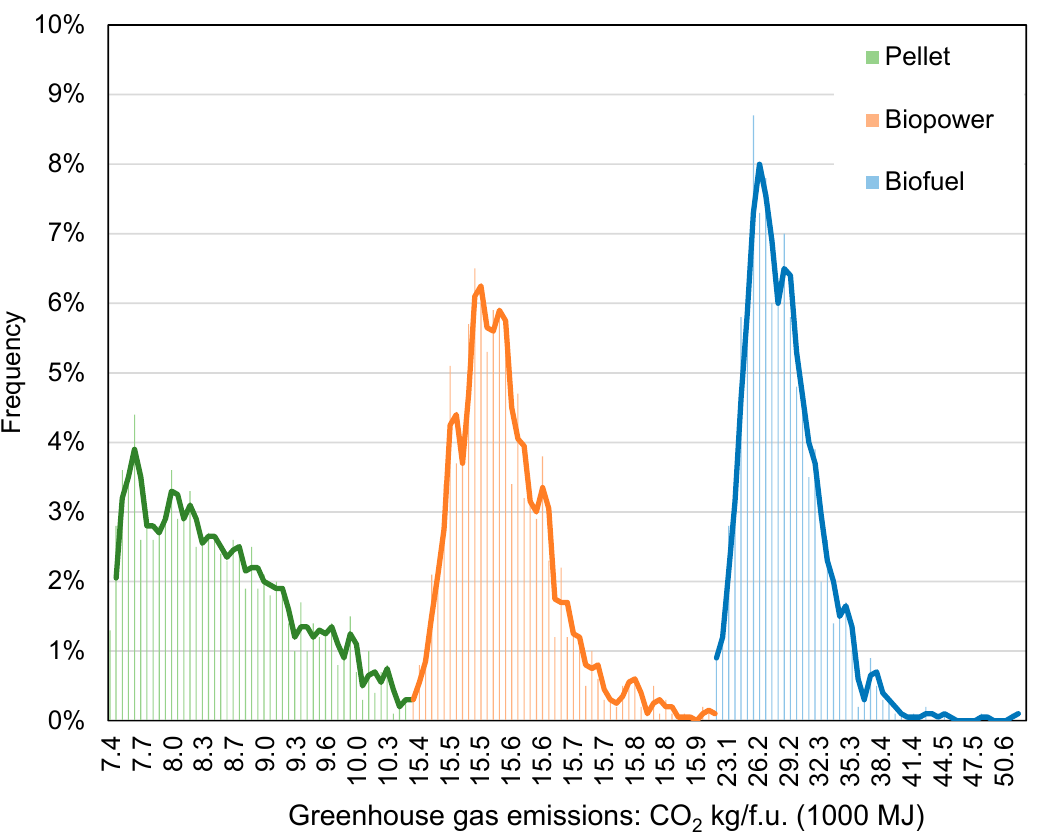
Figure 5. Uncertainty of greenhouse gas emission for pellet, biopower, and biofuel.